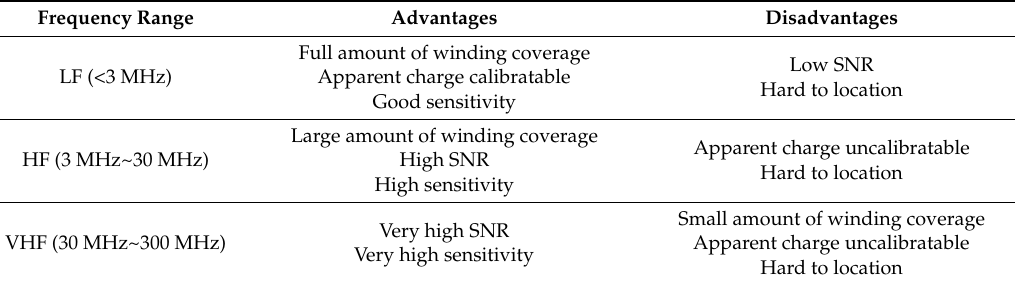
Table 4. Comparison of different detection frequency range